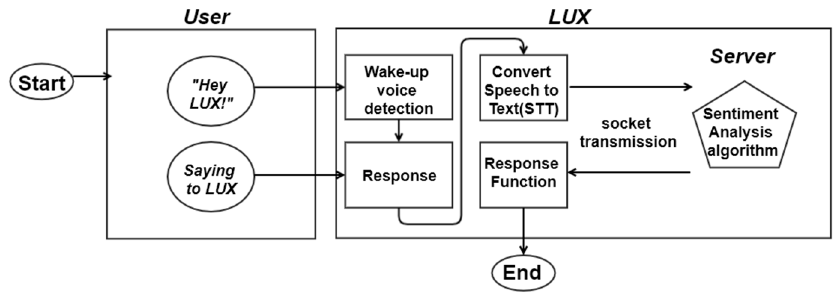
Figure 1. The proposed software framework of smart mirror LUX.